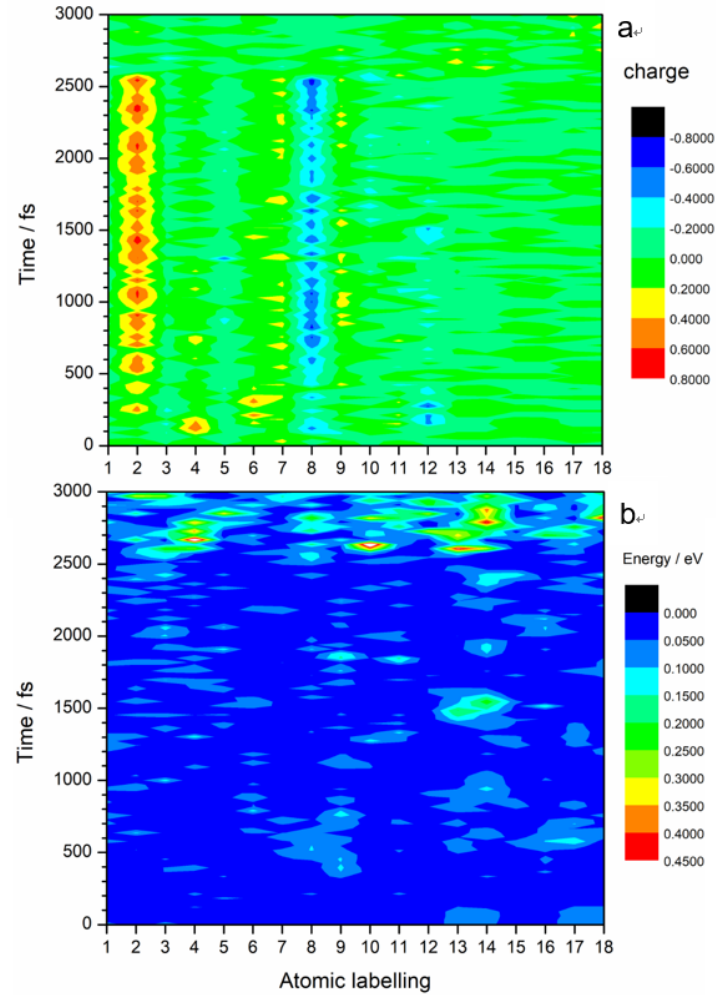
Figure 4. Distribution contours of ( a ) charge and ( b ) kinetic energy of each atom of TATB at current excited state. Atomic labeling displayed in the x ‐ axis is the same as in Figure 1a. The hydrogen atoms were ignored.